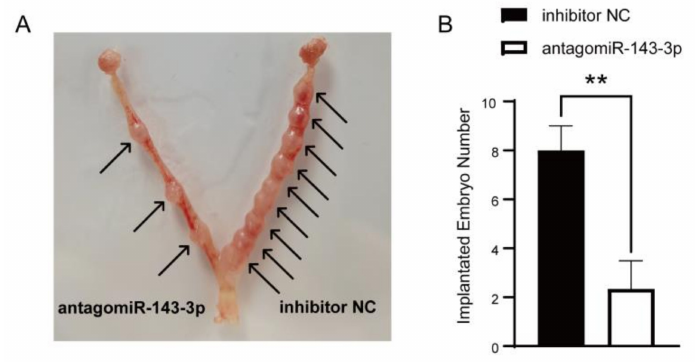
Figure 7. Inhibition of mouse embryo attachment by antagomiR-143-3p. ( A , B ) Comparison of the number of embryos implanted with antagomiR-143-3p or inhibitor negative control (inhibitor NC) injected in uterine horns. ** p <